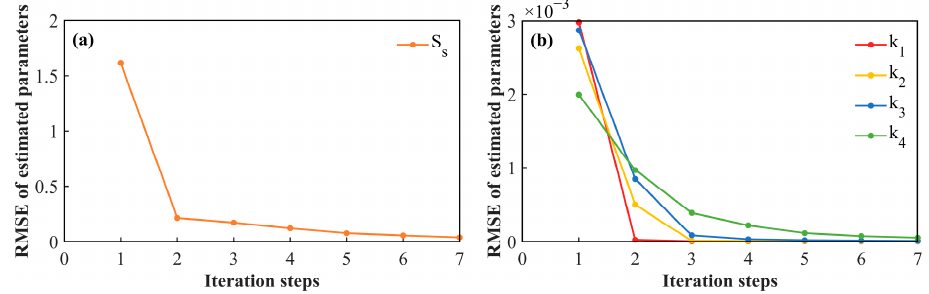
Figure 6. The RMSE of model parameters estimated in Case 1. ( a ) represents the RMSE of source strength at different iteration steps. ( b ) represents the RMSE of rate constants of the reactive transport model at different iteration steps. Different coloured lines denote the RMSE of each parameter at different iteration steps.